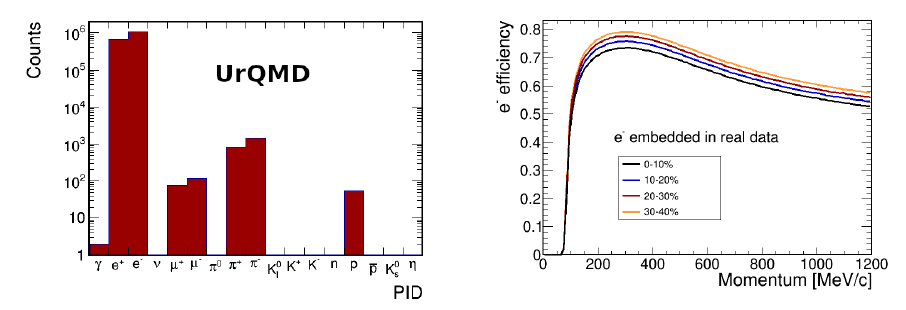
Figure 1. Left: Particle abundances in UrQMD simulations (90 million collisions) after applying the electron selection criteria used in data. Right: Electron e ffi ciency as a function of momentum and centrality (track density) obtained from simulated electron tracks embedded into real